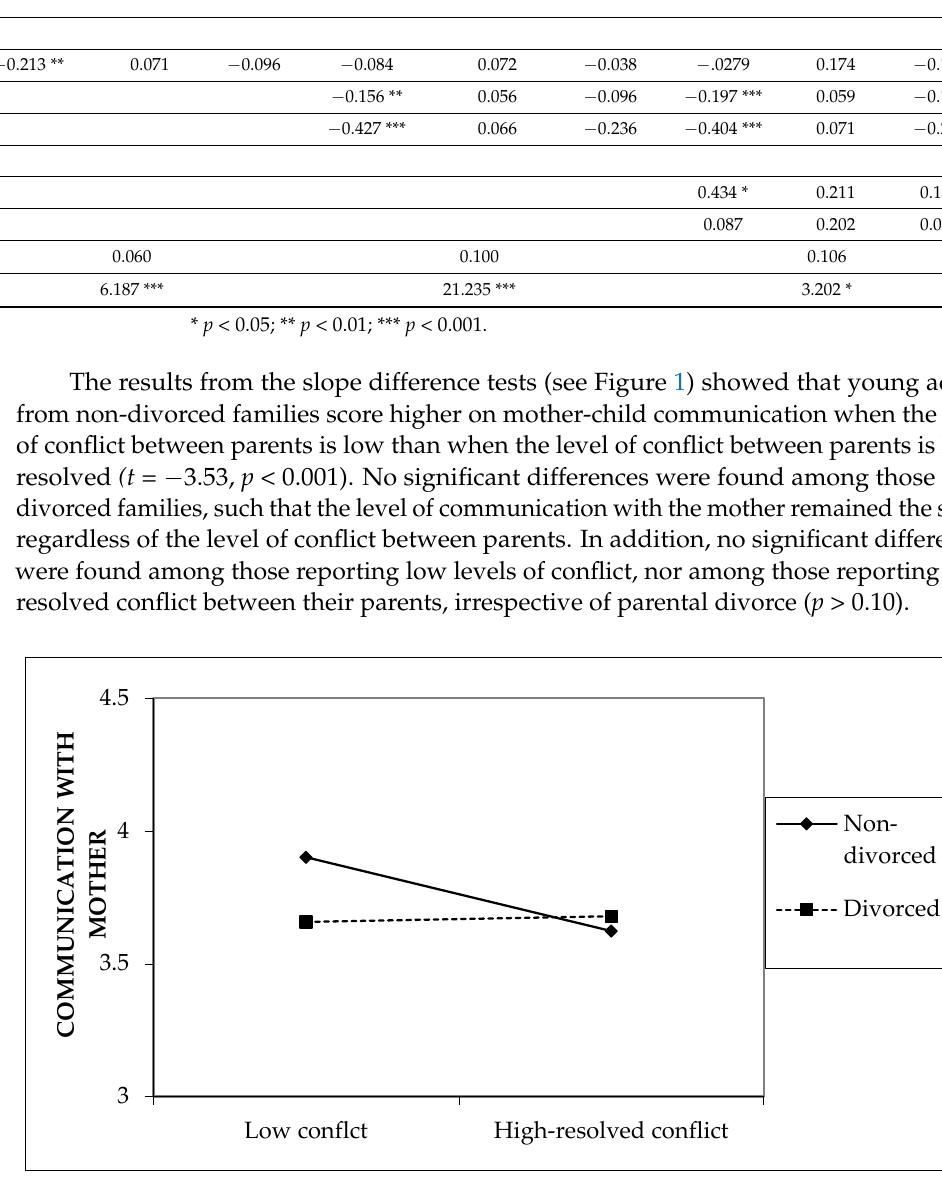
Figure 1. Interaction plot for the significant two-way interaction between parental divorce and high resolved interparental conflict on communication in mother-child relationships. Parental divorce was associated with higher alienation in mother-child affective rela- tionships (Table 5; Model 1). Again, when both interparental conflict levels were added (Model 2), parental divorce was no longer significant and both high resolved and high unre- solved parental conflict were positively associated with mother-child alienation, even when interactions between parental divorce and interparental conflict were added (Model Table 5. Summary of the hierarchical multiple regressions for the variables predicting alienation in mother-child relationships.